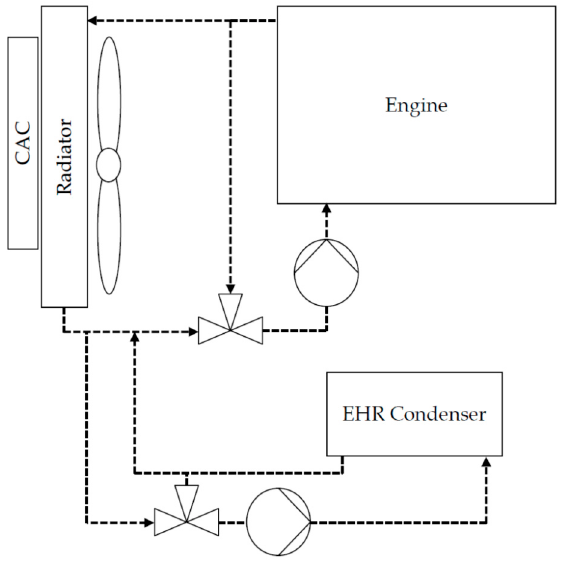
Figure 3. Floating temperature cooling system.